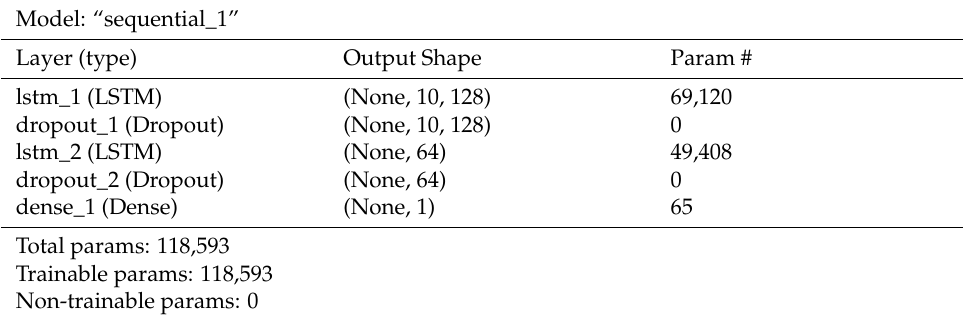
Table 5. Information following two training